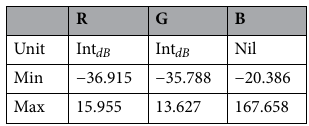
0 values in different bands.